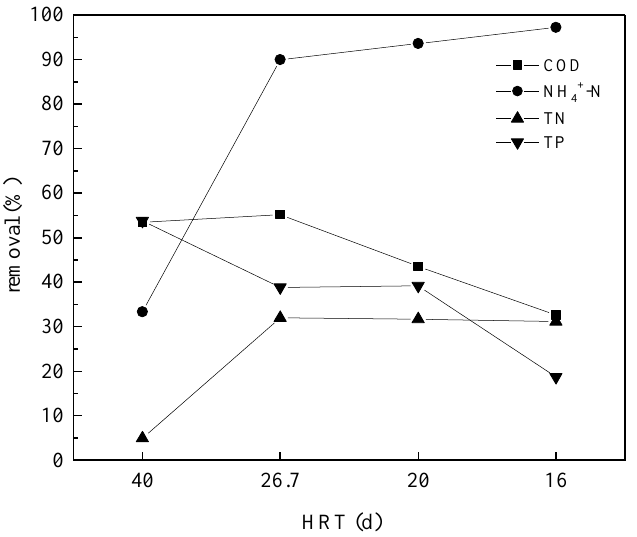
Figure 5. COD , NH 4 + -N, TN, and TP removal under different HRTs in ALBR system RES Figure 5. COD, NH 4+ -N, TN, and TP removal under different HRTs in ALBR system RES reduc- tion.